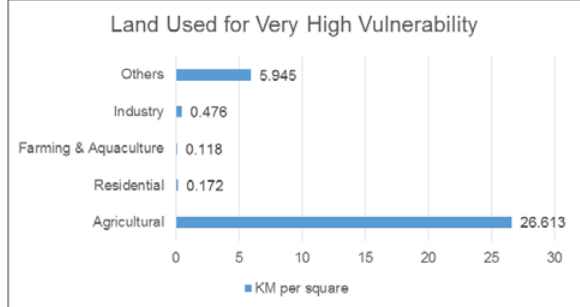
Figure 19. Land Used for Very High